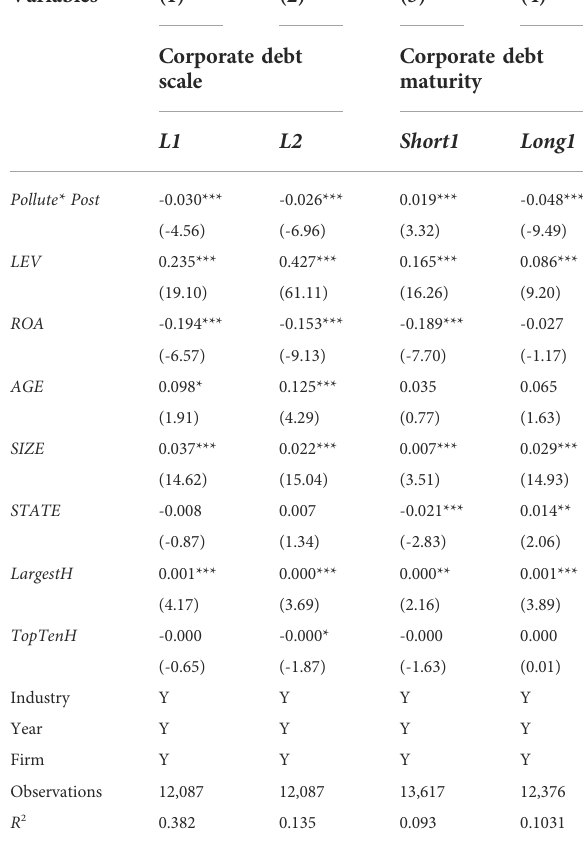
TABLE 3 Empirical results of green credit policy on the scale and maturity of Corporate Debt